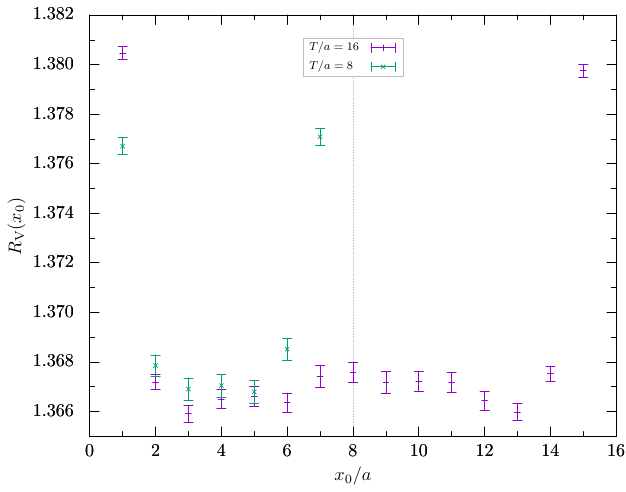
Figure 2. Euclidean time (in)dependence of R V at (cid:12) = 4 : 0 for L=a = 8 ; 16 lattices. Straight line interpolations take all correlations into account for the data shown here. Except for the points closest to the boundaries, there is no statistically signi(cid:12)cant x 0 -dependence.